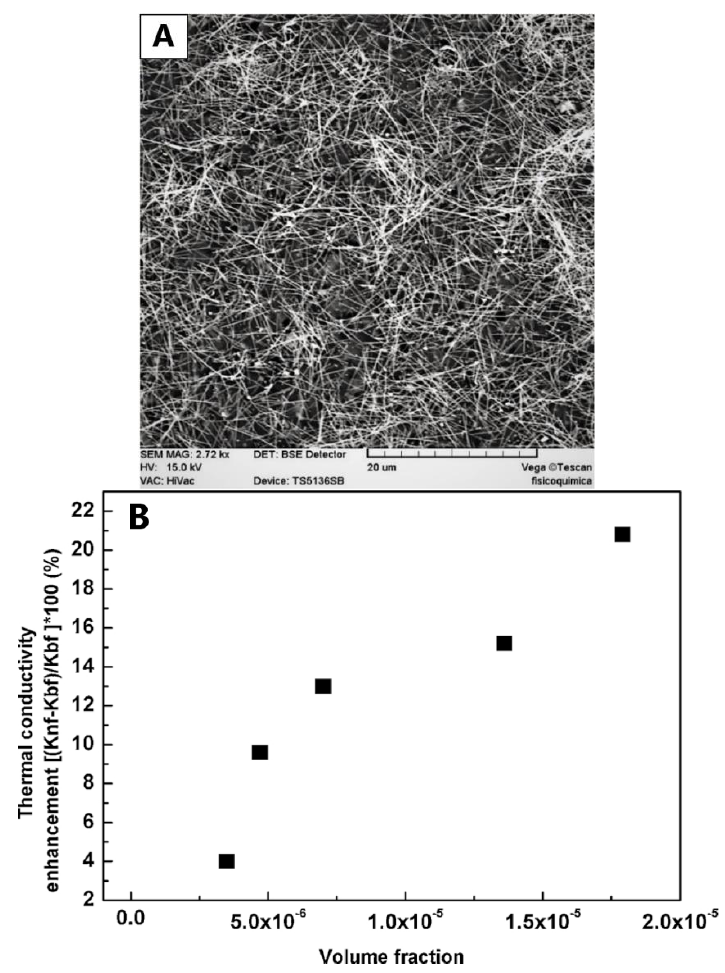
Figure 15. ( A ) SEM image of AgNWs (magnification 2750) and ( B ) thermal conductivity enhancement of nanofluids with different volume fractions of AgNWs [80].